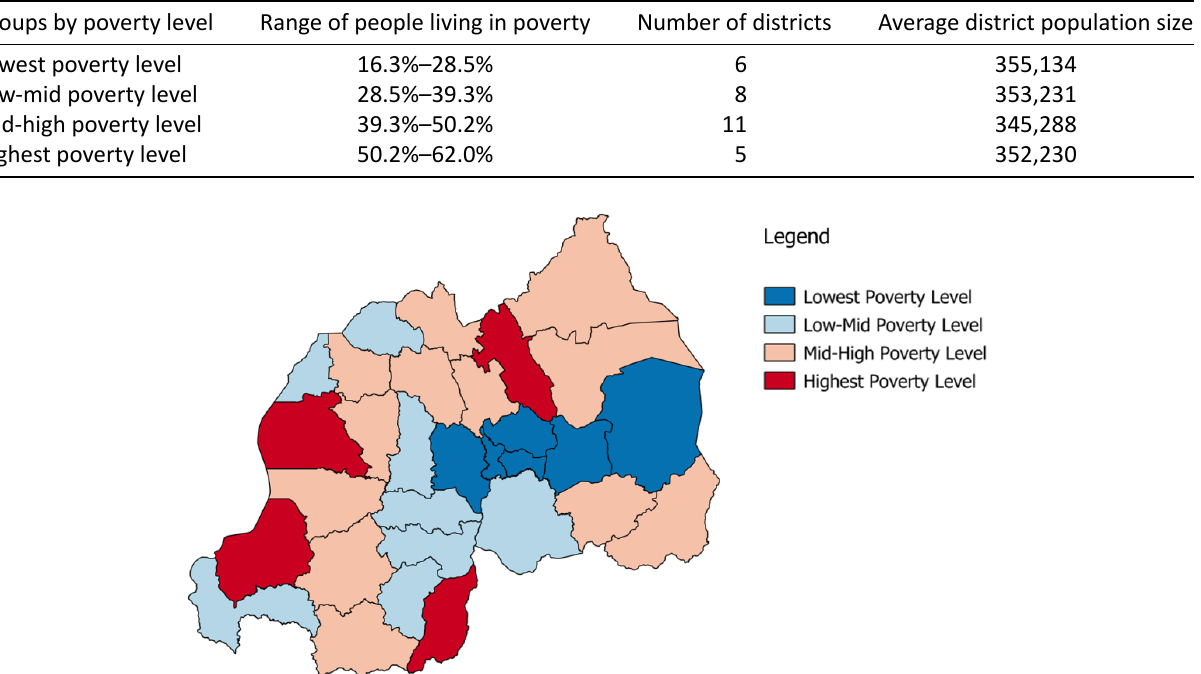
Figure 2. Four levels of poverty in the districts, from the least poor (in blue) to the poorest (in red). Source: